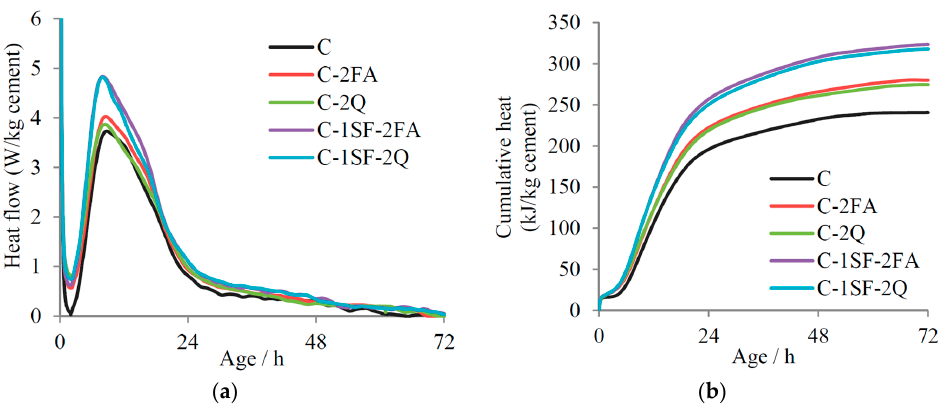
Figure 2. Early-age hydration heat before and after quartz replacement: ( a ) Heat flow; and ( b ) Cumulative heat.